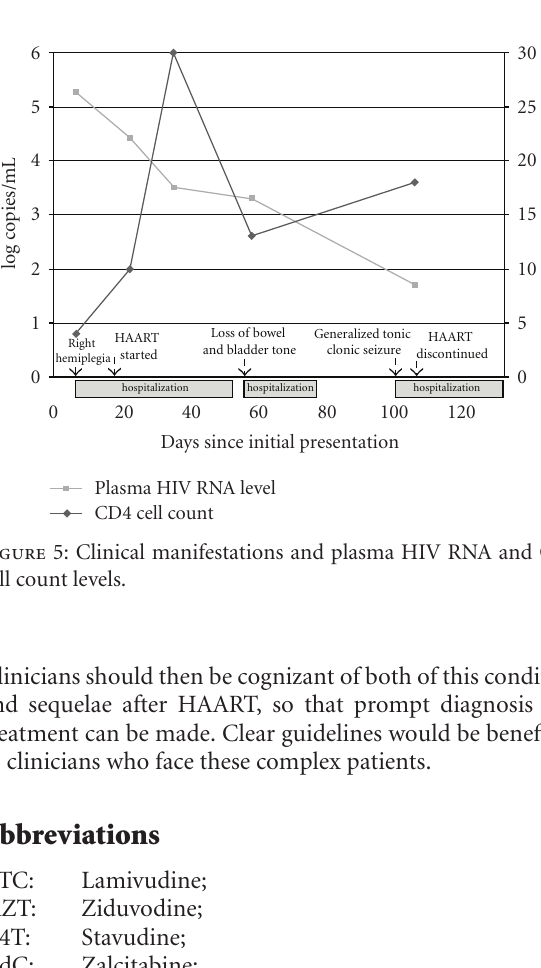
Figure 3: 2nd MRI, 3 1/2 months after onset of symptoms, 3days post-HAART cessation.